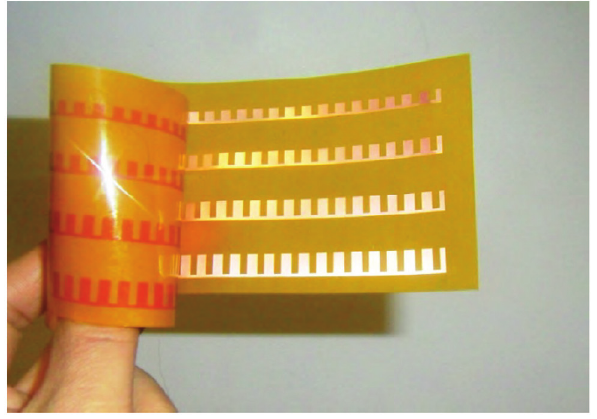
Figure 10: The fabricated sample of the flexible and ultrathin plasmonic metamaterials using FCCL. Reproduced from [40] with permission.